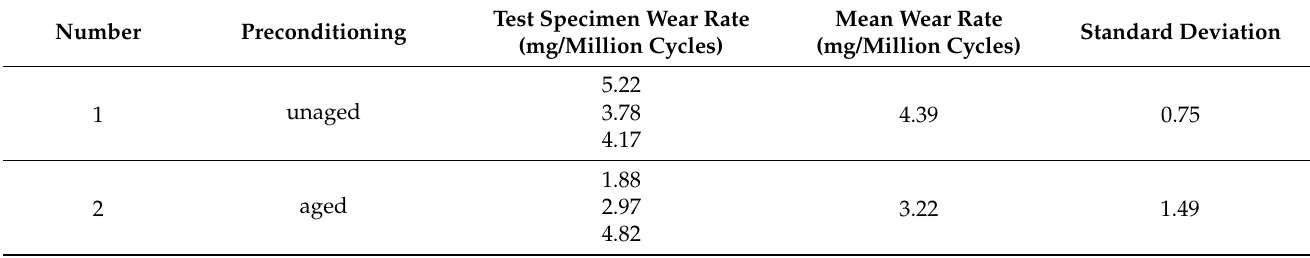
Table 3. Wear rate after 5 million cycles.